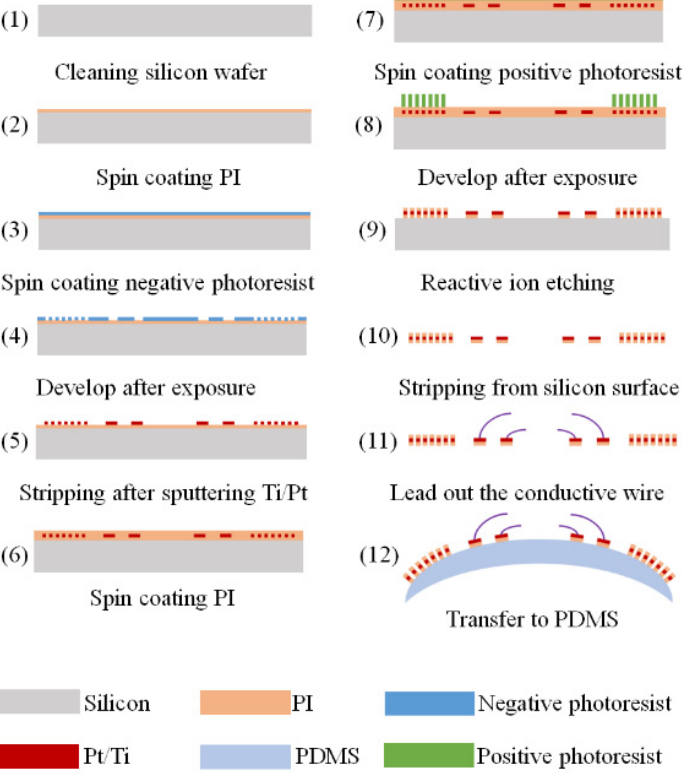
Figure 3. Physical image of ( a ) strain gauge and ( b ) contact lens sensor. 4. Testing 4.1. Setup of the Testing Systems